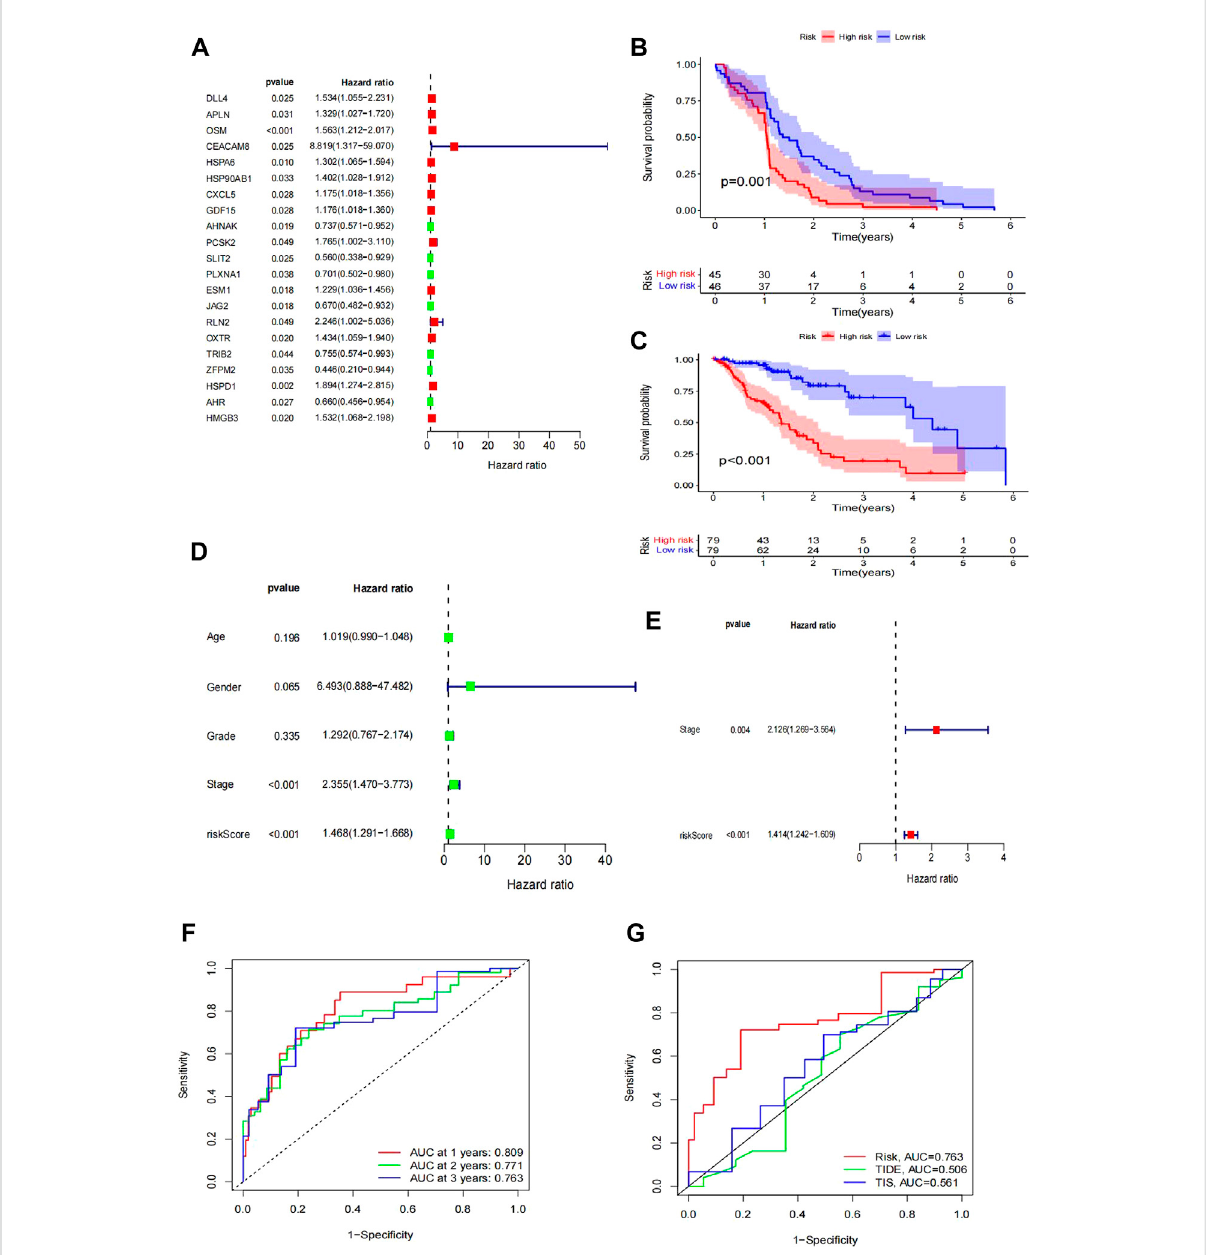
FIGURE 3 Construction of the IRG signature as a prognostic model. (A) Forest plot of hazard ratios showing the prognostic values of genes, in which the unadjusted hazard ratios, as well as the corresponding 95% con fi dence intervals, are displayed. (B – C) Survival plot of patient prognosis. (B) Survival analysis between the high-risk group and low-risk group of the TCGA test group. (C) Survival analysis between the high-risk group and low-risk group of the GEO training group. Forest plot of univariate and multivariate Cox regression analyses. (D – E) Uni-forest of the clinicopathological parameters: age, sex, grade, stage, and risk score of 171 EC patients. (E) Multi-forest of the clinicopathological parameter stage and risk score of the eight-genemodule. (F – G) Comparisonofthemodulesweestablished. (F) ROCcurvelinesofthepatientat1 year( p =0.809),2 years( p =0.771),and 3 years ( p = 0.763). (G) Comparison of the curve under the risk AUC ( p = 0.763), TIDE AUC ( p = 0.506), and TIS AUC ( p = 0.561)